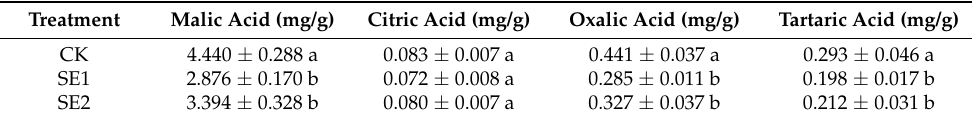
Table 5. Effects of organic fertilizer on the contents of malic acid, citric acid, oxalic acid and tartaric acid in ‘Fuji’